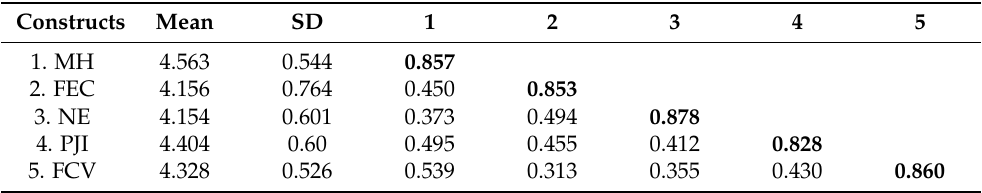
Table 3. Inter-construct correlation and discriminant